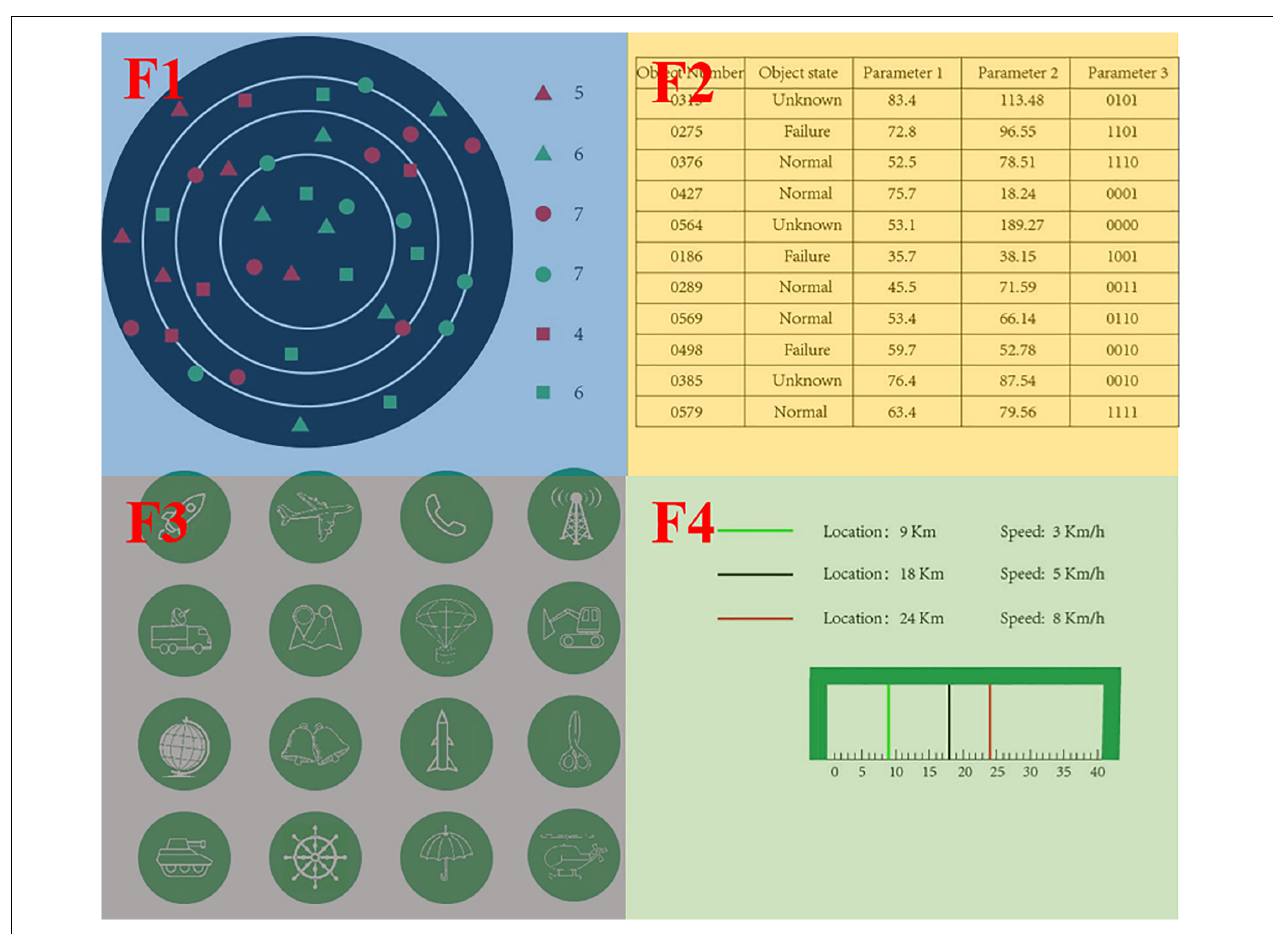
FIGURE 3 | Experimental interface.